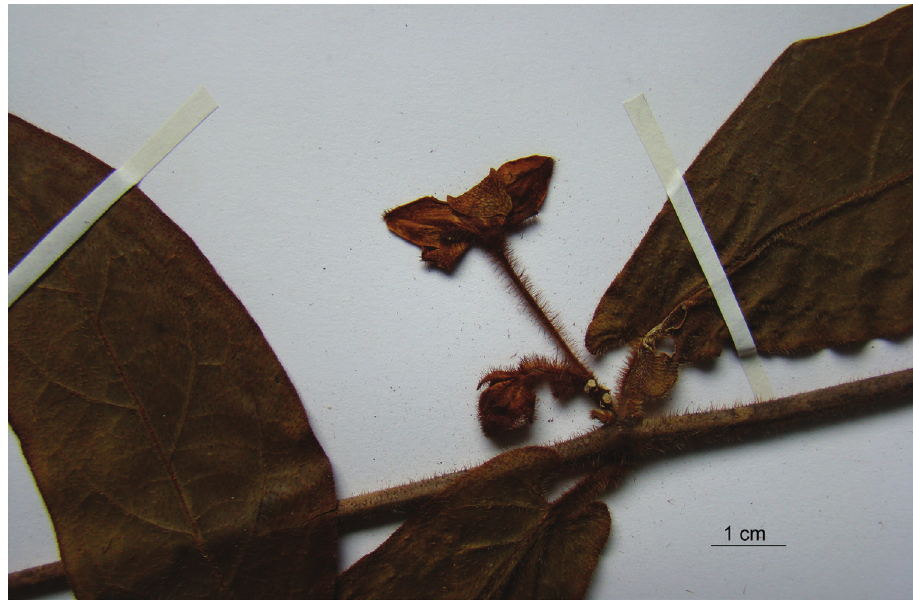
Figure 5. Detail of flower (side view) of Phaeostemma surinamensis from holotype ( Lindeman et al. 654 , U).